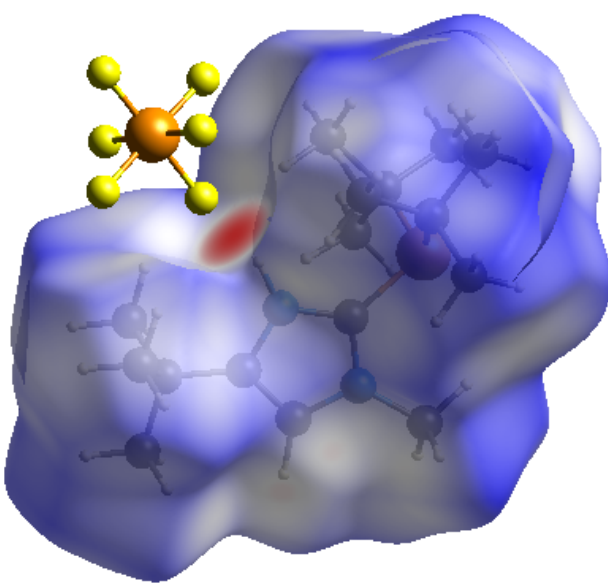
Figure 2. Hirshfeld surface analysis of complex 1 (red contours indicating close contacts).